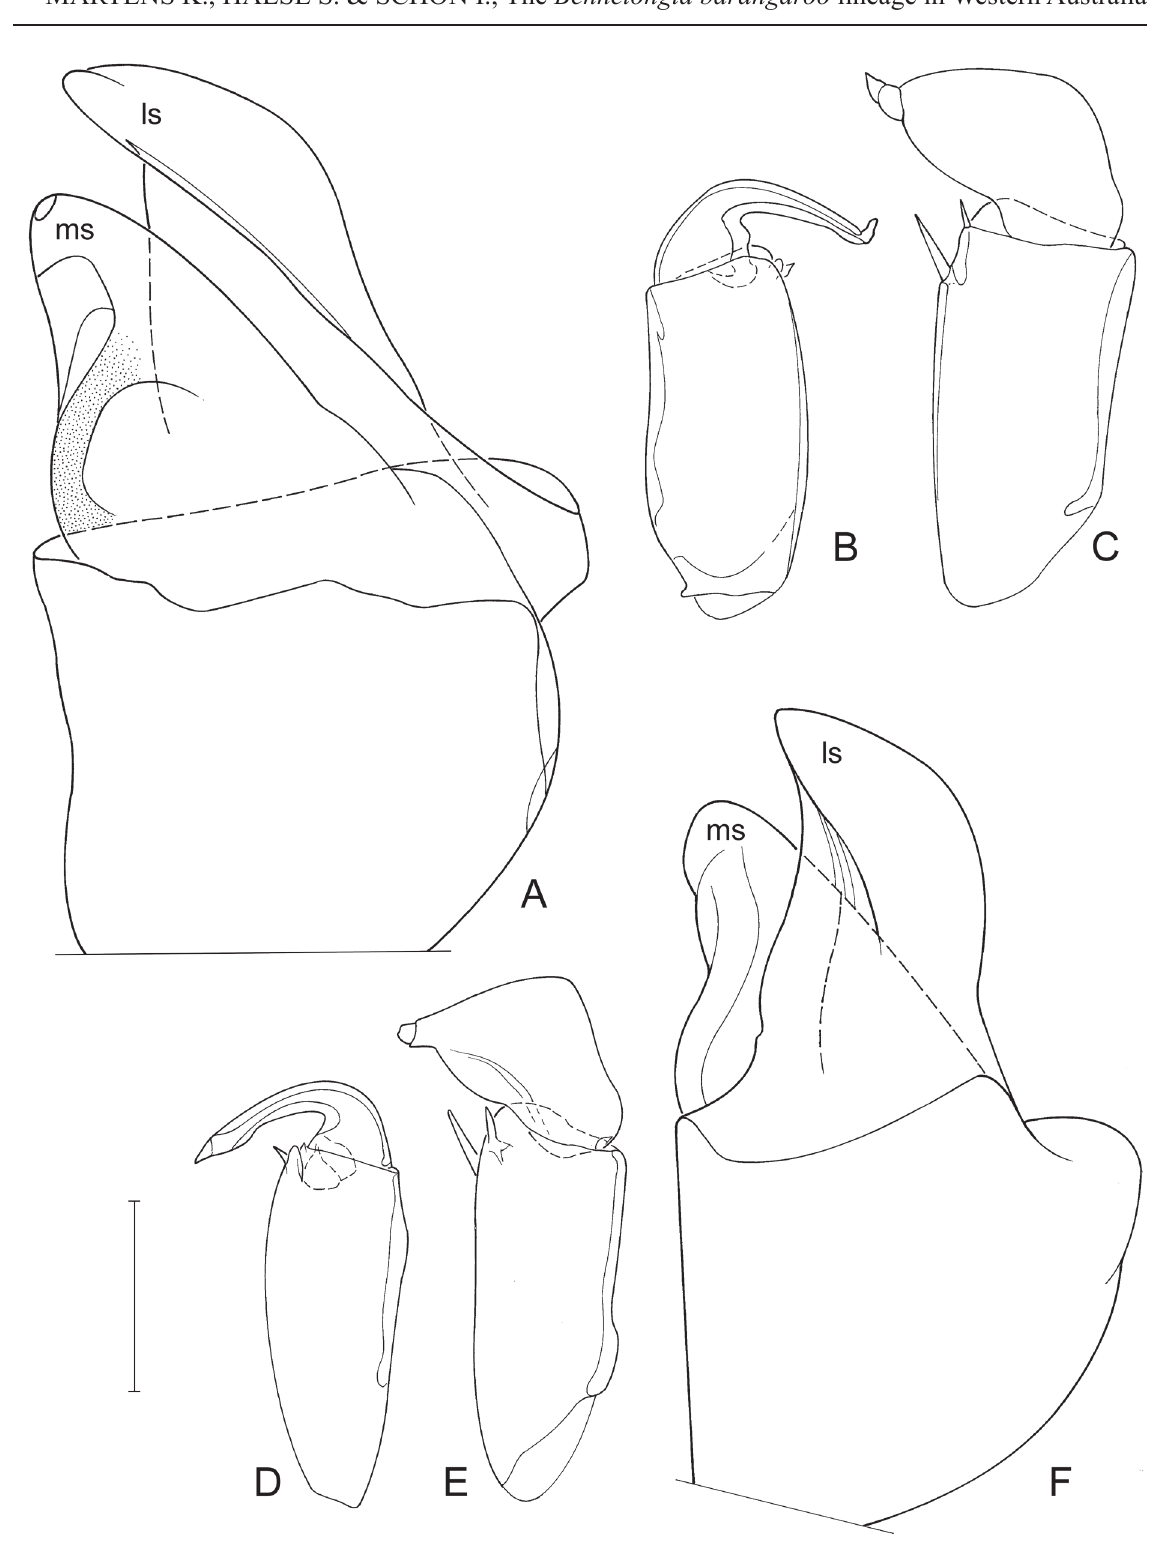
Fig. 17. Bennelongia mcraeae sp. nov., type males from type locality (arro lake, Ostr014B). — A-C . Holotype ♂ (WAMC52286). A . Hemipenis. B . left prehensile palp. C . right prehensile palp. — D-F . Paratype ♂ (OC.3328). D . left prehensile palp. E . right prehensile palp. F . Hemipenis. scale: a-F = 92